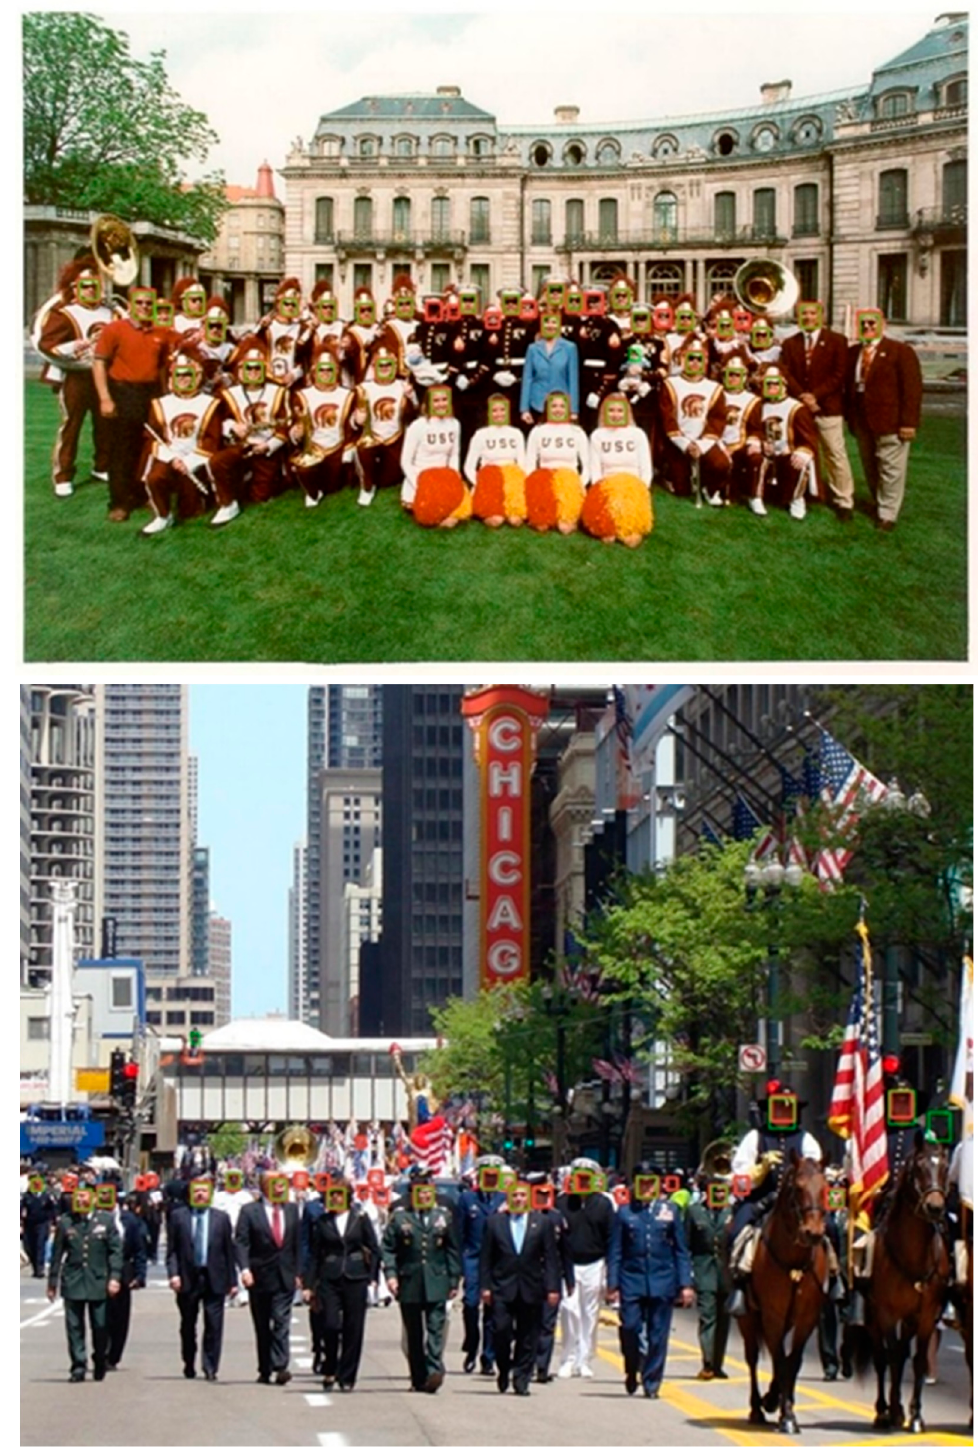
Figure 8. Face detection on the WIDER-FACE dataset.